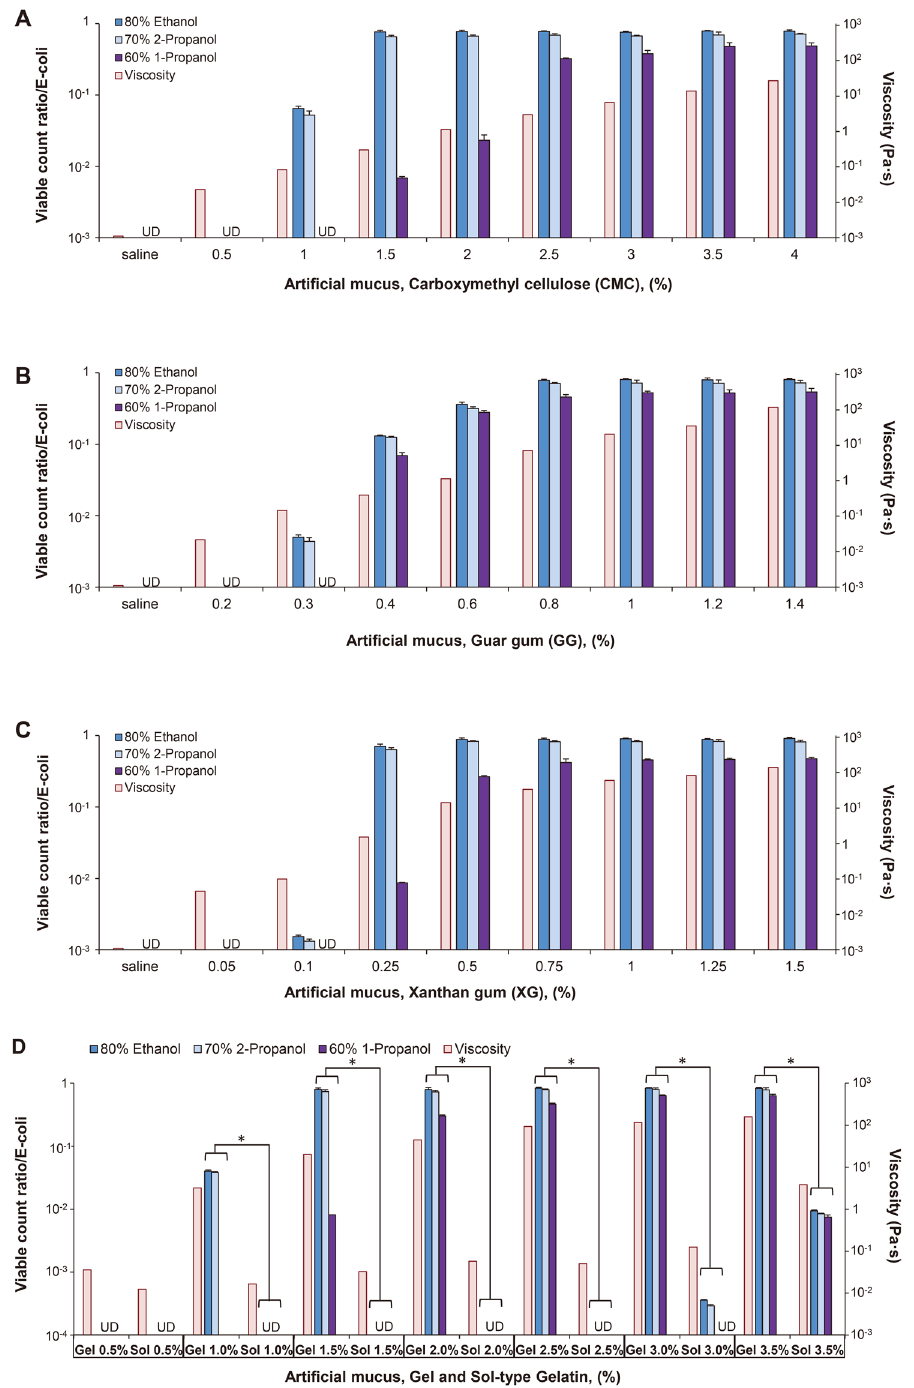
Figure 2. Artificial mucus protects bacteria ( E. coli ) against alcoholic disinfectants. E . coli ( E . coli K12 NCTC 10538) was mixed with artificial mucus and incubated for 30 s with alcohol-based disinfectants before viable count ratio was measured. Viscosity of artificial mucus and viable count ratios when E . coli was mixed with carboxymethyl cellulose-based ( A ), guar gum-based ( B ), xanthan gum-based ( C ), and gelatin-based ( D ) artificial mucus followed by incubation with alcohol- based disinfectants. Viable count ratio was defined as the ratio of the viable count measured after incubation with disinfectant to the viable count measured after incubation with PBS alone. The viable count ratio reflected the proportion of bacteria ( E . coli) that was not inactivated by the disinfectant. Data are expressed as mean ± S.D. of at least three independent experiments. UD, undetectable. * P <